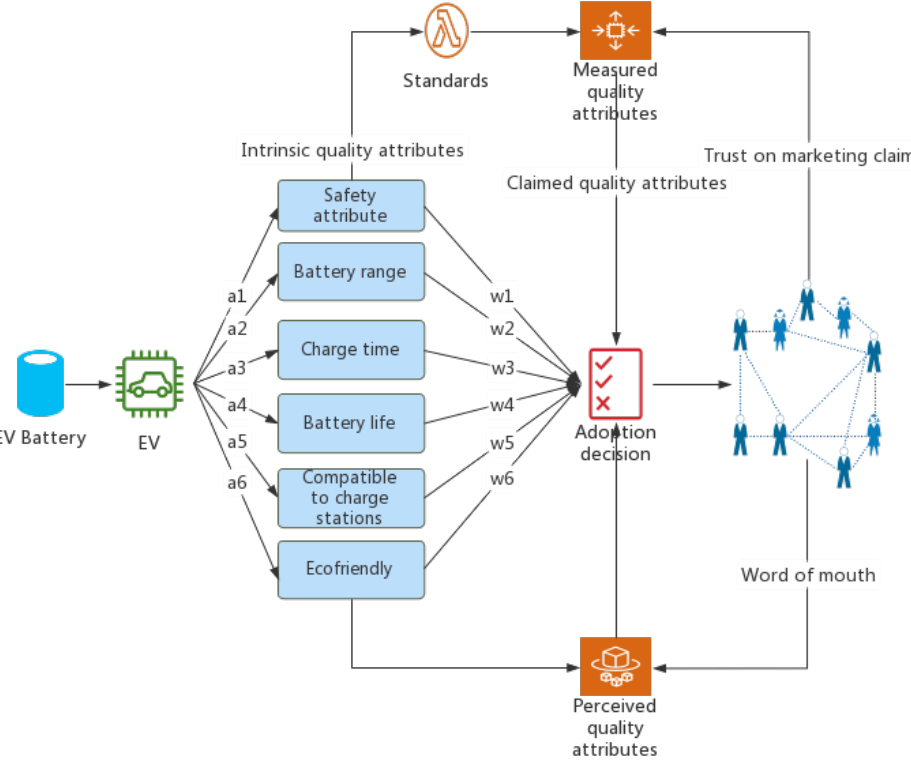
Figure 5. Quality attributes’ effect on consumer adoption.